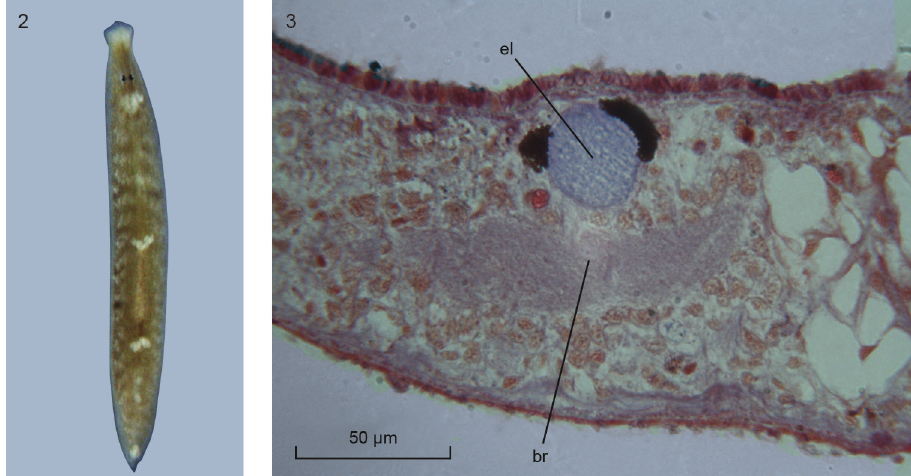
Figures 2–3. Paucumara trigonocephala . 2 Dorsal view of live specimen from South Korea. Scale bar not available 3 ZMA V.Pl. 7279.1, microphotograph of eye lens; anterior to the